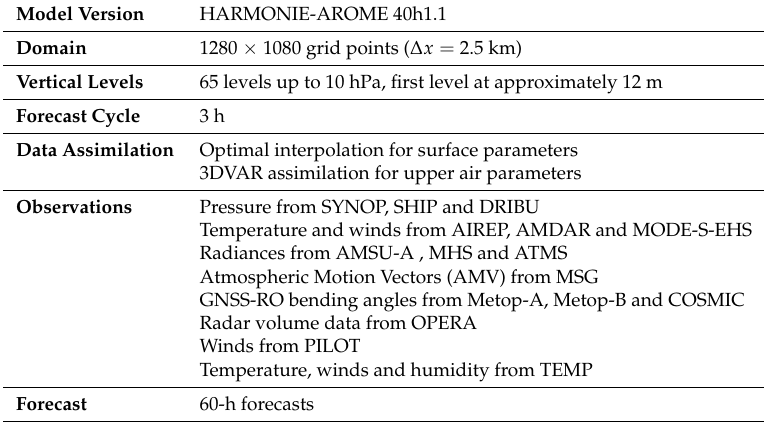
Table 2. HARMONIE-AROME configuration used for the Danish Meteorological Institute (DMI) Northern Europe A (NEA)